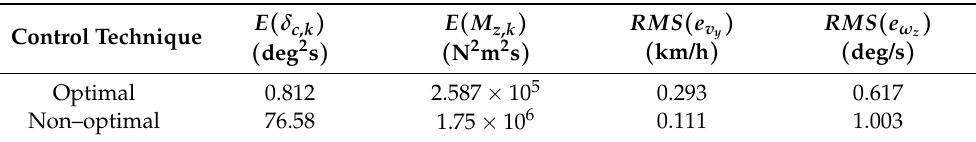
Table 3. Comparison between optimal and non–optimal control efforts in terms of command energy spectral density E ( · ) and root mean square error RMS ( · )